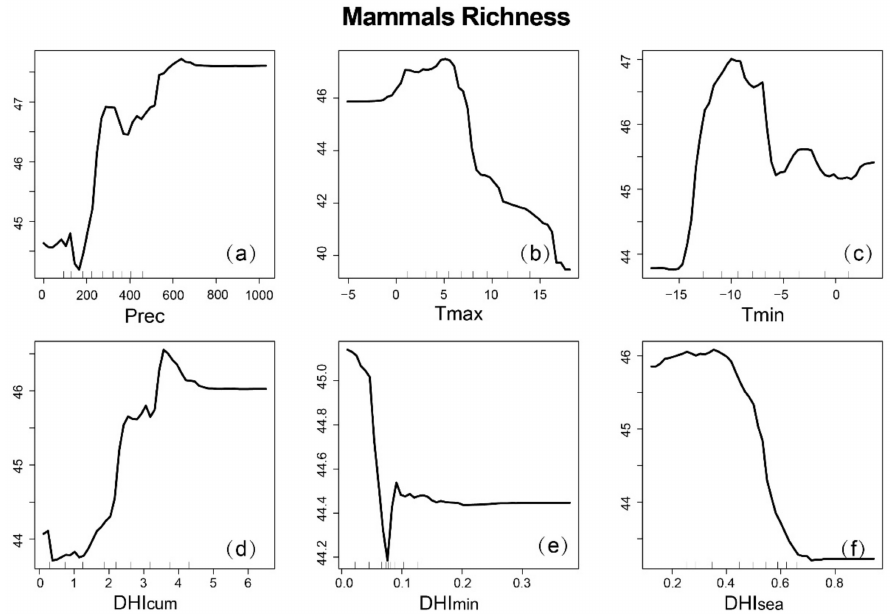
Figure 9. Partial dependence map of mammal richness based on RF, depending on climatic variables and dynamic habitat indices (DHIs): ( a ) annual cumulative precipitation; ( b ) annual maximum temperature; ( c ) annual minimum temperature; ( d ) DHI cum ; ( e ) DHI min ; ( f ) DHI sea .